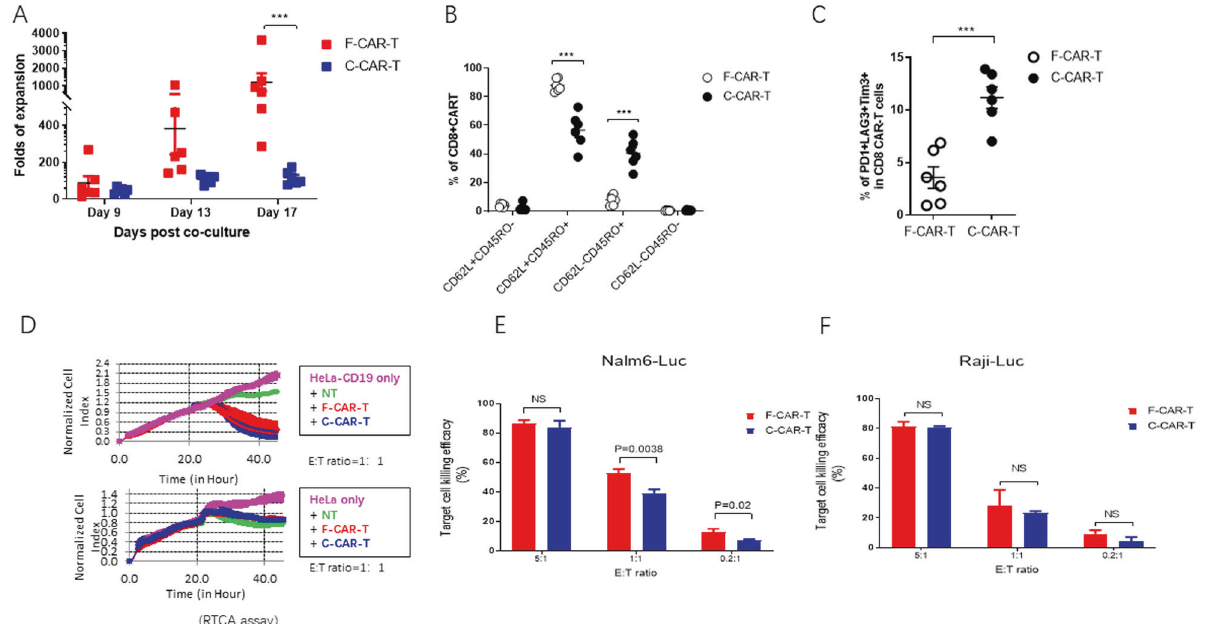
Fig. 1 Characterization of F-CAR-T in vitro. A Ex vivo cell proliferation of F-CAR-T and C-CAR-T derived from B-ALL patients ( n = 6) (*** P = 0.001, F-CAR-T vs. C-CAR-T, d17, unpaired student two-tailed t -test). B Tscm, Tcm, and Tem were characterized by surface staining of CD45RO and CD62L and analyzed with fl ow cytometry (*** P < 0.001 comparing F-CAR-T and C-CAR-T). C T-cell exhaustion was characterized by PD-1, LAG3, and TIM-3 staining; Statistical analyses of the percentage of PD1 + LAG3 + Tim3 + (*** P < 0.001, comparing F-CAR-T and C-CAR-T), unpaired student two-tailed t -test). D RTCA assay was used to examine the speci fi c killing of HeLa-CD19 cells. Growth of target HeLa-CD19 or HeLa cells were monitored dynamically. E CD19 + target Nalm6-Luc cells or F Raji-Luc cells were co-cultured with either F-CAR-T or C-CAR-T for 6 h. Target cell killing ef fi cacy was calculated by luciferase activity. NS, P > 0.05 F-CAR-T vs. C-CAR-T (unpaired student t -test, two-tailed). F-CAR- T FasT CAR-T, C-CAR-T conventional CAR-T, Tcm (CD45RO + CD62L + ) T central memory cells, Tem (CD45RO + CD62L − ) T effector memory